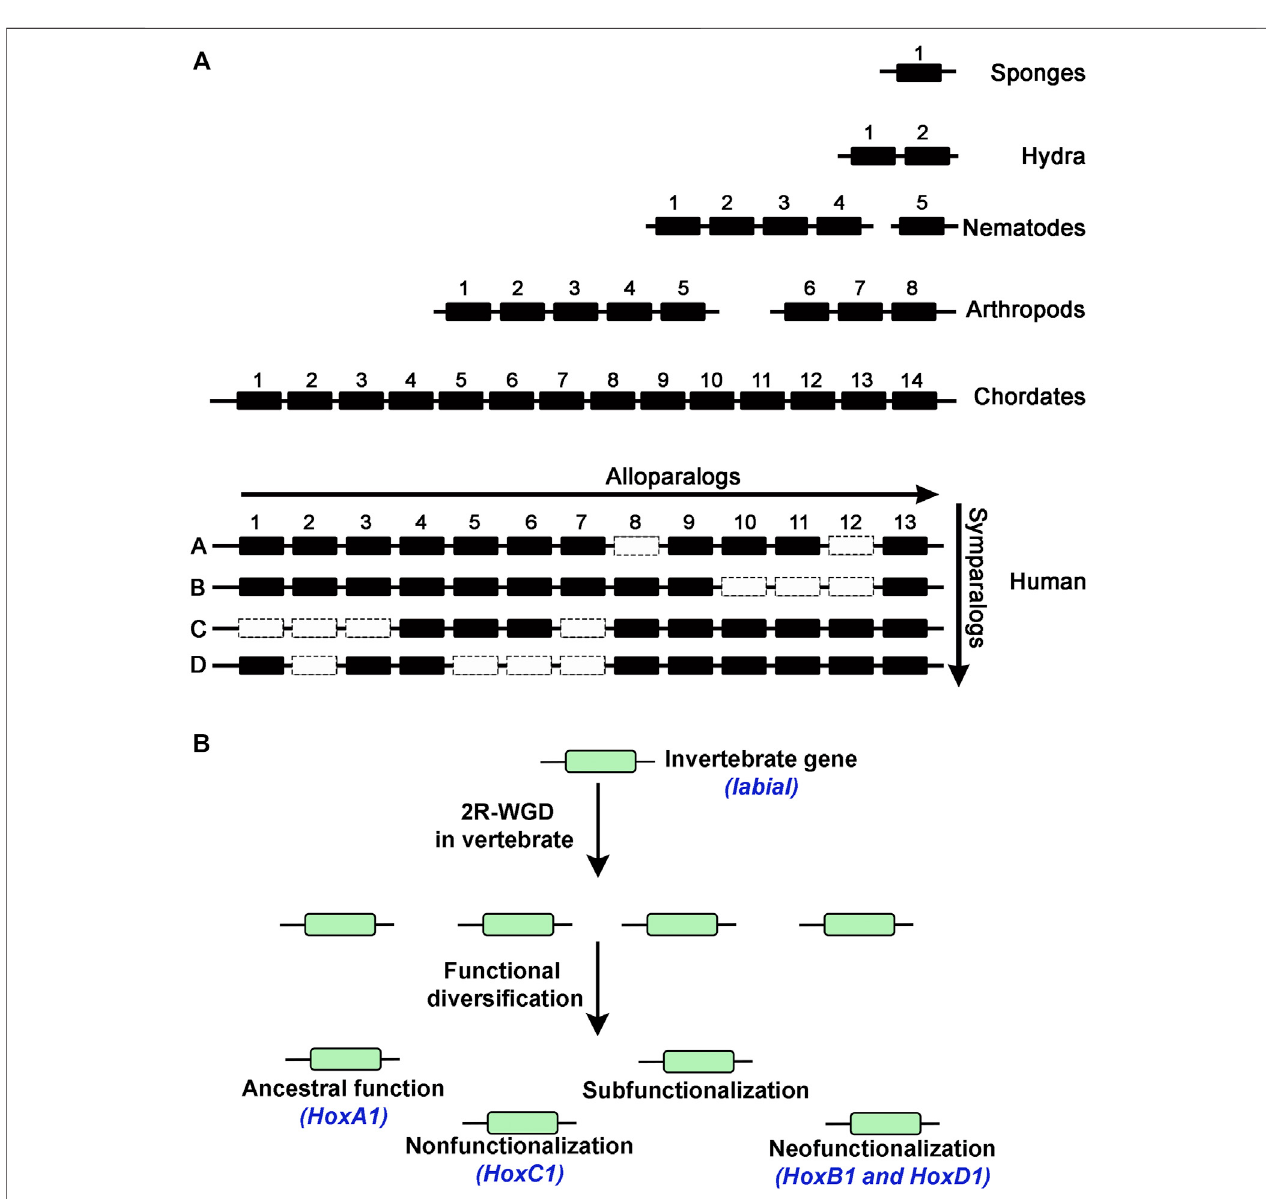
FIGURE3|(A) Diagramshowsnumberof Hox genesindifferentanimalsindicatingexpansionoftheHoxclusterintoalloparalogs.Duplicationeventsinvertebrates generated 4 Hox clusters to create symparalogs, Human genome has 39 Hox genes suggesting loss of some genes (dotted box) during evolution. (B) Possibilities of functional diversi fi cation of duplicated genes in the vertebrate genome after duplication. An example of the invertebrate labial gene from Drosophila , duplication in vertebrates and functional diversi fi cation of the homologous Hox1 genes (blue text).